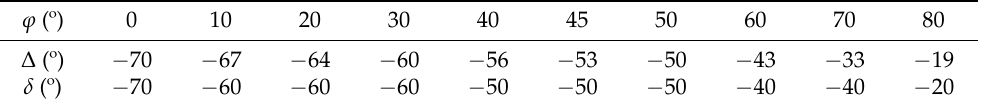
Table 2. Comparison of theoretical value ∆ and calculated result δ for different inclination angles ϕ (degree).